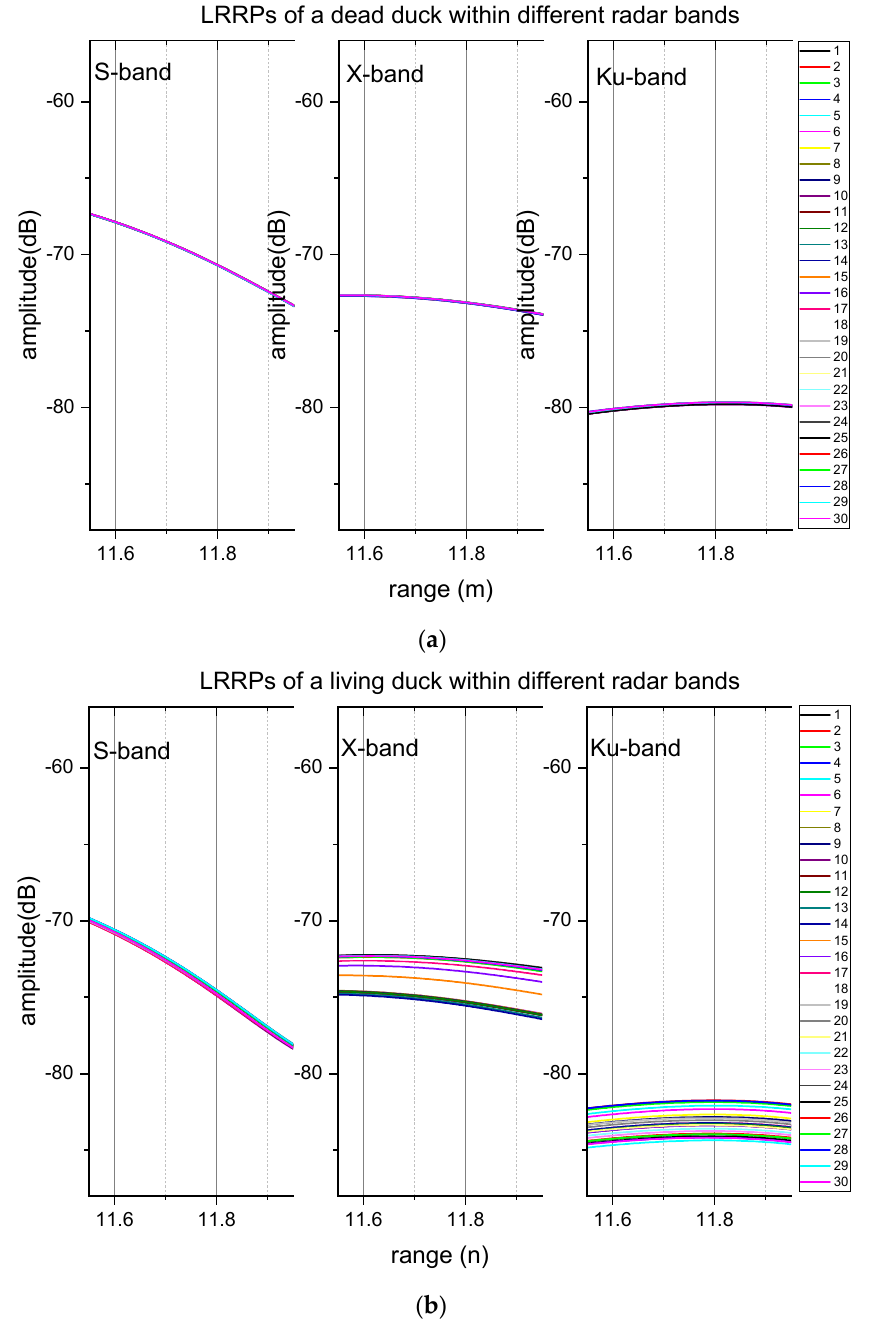
Figure 4. The comparison of LRRPs of a living duck and a dead duck 1,2 . ( a ) LRRPs of a dead duck, ( b ) LRRPs of a living duck. 1 The ducks were in positions around 11.8 m of the range profiles. 2 The numbers of the legends on the right bar are the sequence number of the sampling frame.